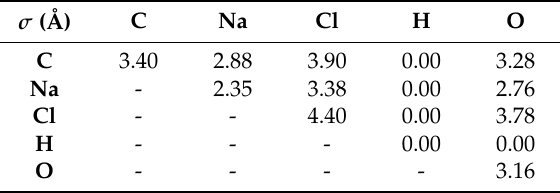
Table 1. Parameter σ in the Lennard-Jones potential.